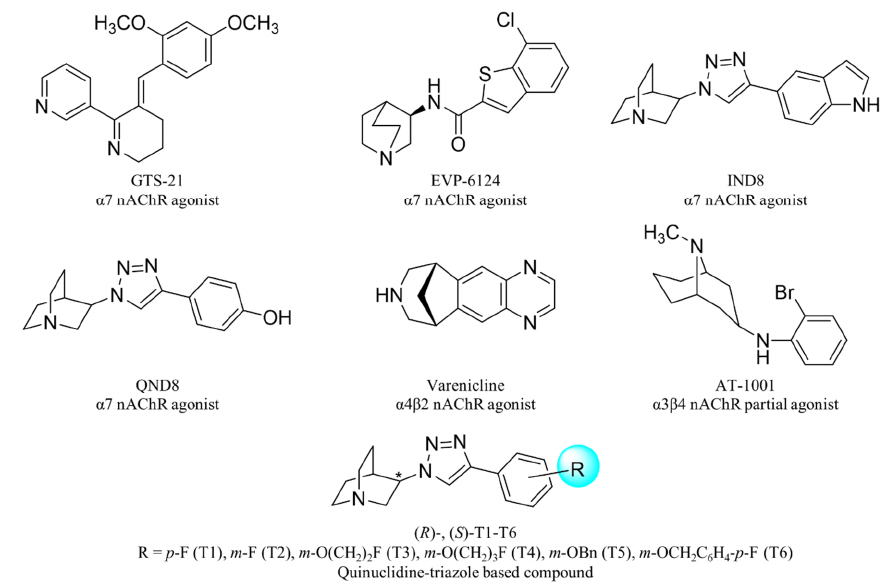
Figure 1. Examples of nicotinic acetylcholine receptor (nAChR) ligands.